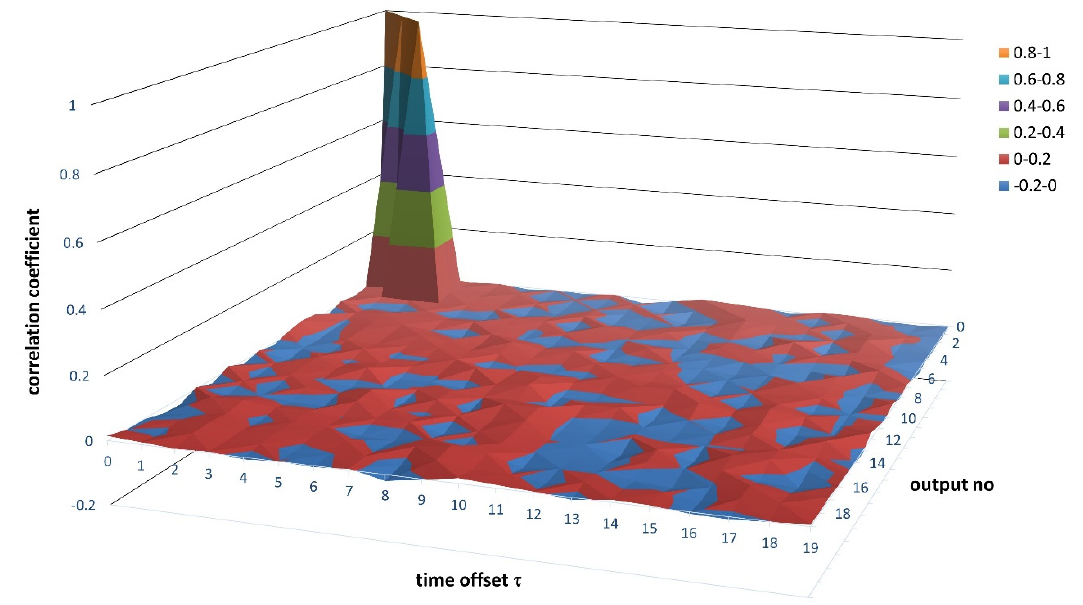
Figure 9. The graph for the correlation coefficient for the DT-LFSR with the D 3 T 17